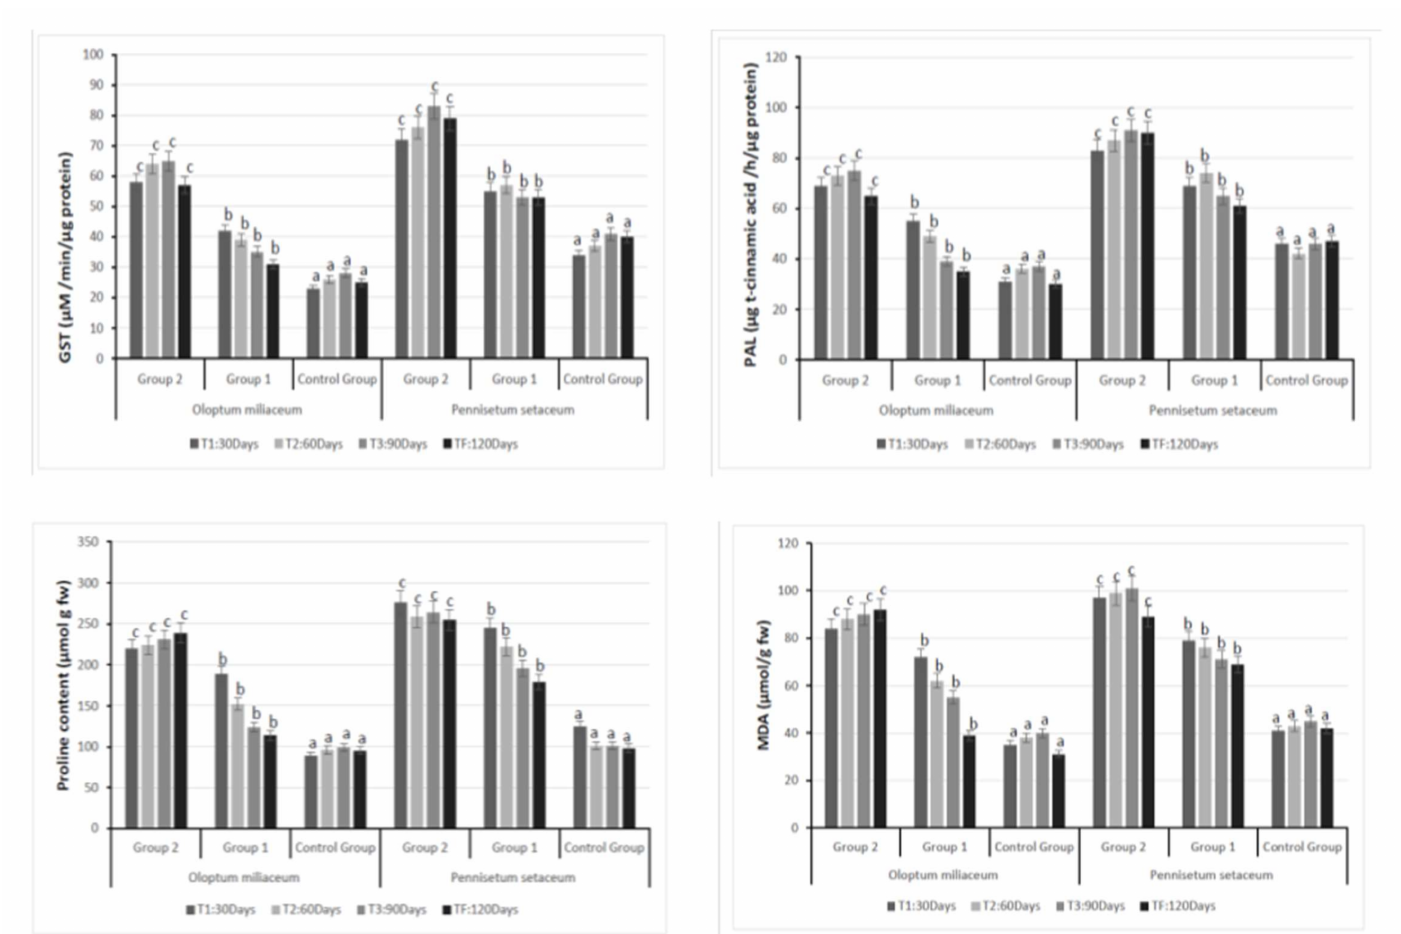
Figure 2. Antioxidant activity of GST ( µ M / min / µ g protein), PAL ( µ g t-cinnamic acid / h / µ g protein), Proline content ( µ mol g fw) and MDA ( µ mol / g fw) in leaves of Oloptum miliaceum and Pennisetum setaceum to Group 1, 2 and Control Group after 30 (T1), 30 (T2), 90 (T3) and 120 (TF) days. Values represent mean ± SE. Di ff erent letters indicate means that are significantly di ff erent from each other (Ducan’s test, p <